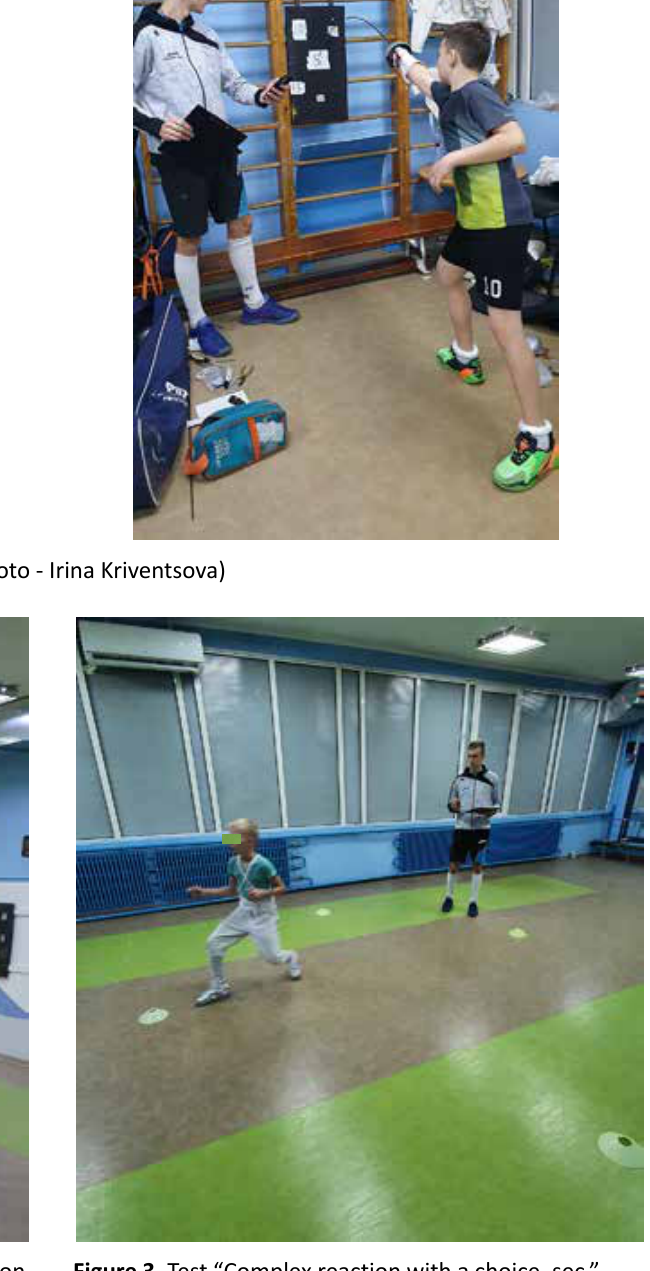
Figure 3. Test “Complex reaction with a choice, sec.”